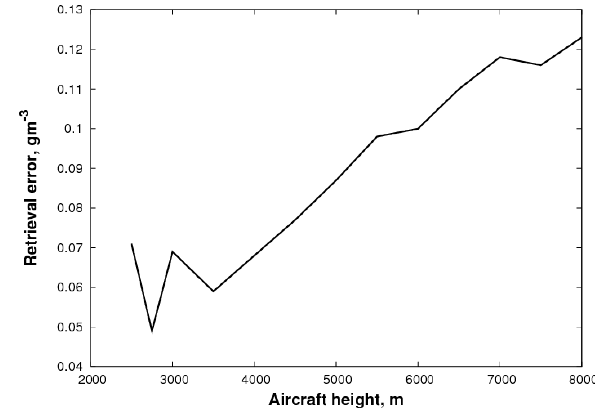
Figure 12. The retrieval error of the airborne setup as a function of aircraft altitude. The altitude of the cloud top is about 2200 m. The retrieval error first decreases with aircraft altitude, reaches a minimum when the aircraft is 500-1500 m higher than the cloud top, and then increases with further increase of aircraft altitude. The stratocumulus cloud case is used for this sensitivity test.